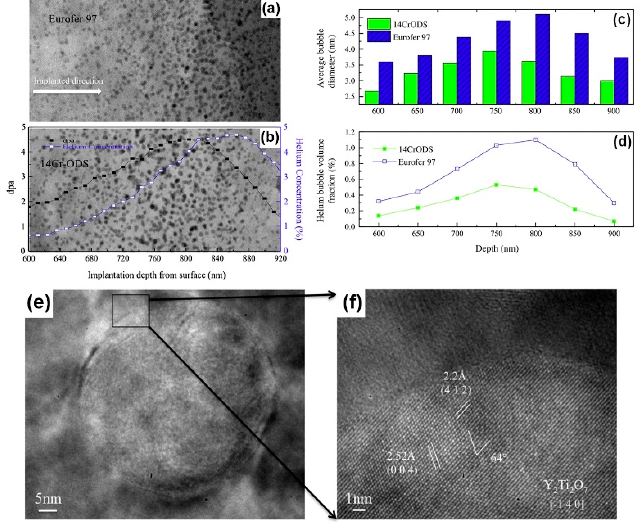
Figure 14. ( a , b ) High-angle annular dark field (HAADF) images of the highest helium concentration regions (600–920 nm from the surface) for Eurofer 97 and 14CrODS steel, overlaid with predicted displacement per atom (DPA) and He concentration profile; ( c , d ) helium bubble distribution (average bubble diameter and helium bubble volume fraction.) versus depth; ( e ) a Y 2 Ti 2 O 7 precipitate; ( f ) HRTEM of the pyrochlore structure Y 2 Ti 2 O 7 [49].